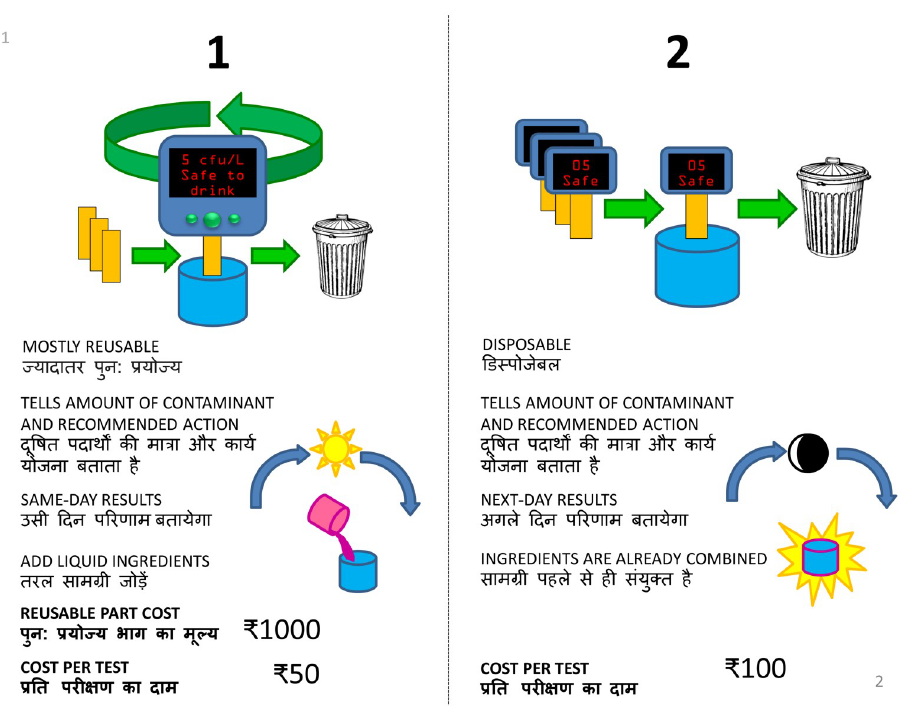
Fig 3. Sample card used for choice-based conjoint analysis interviews. Each conjoint analysis card consists of a choice set containing two profiles for hypothetical bacterial water tests. During each conjoint analysis interview, the participant sequentially considered eight such choice sets and indicated their prefered hypothetical bacterial water test between the two options.